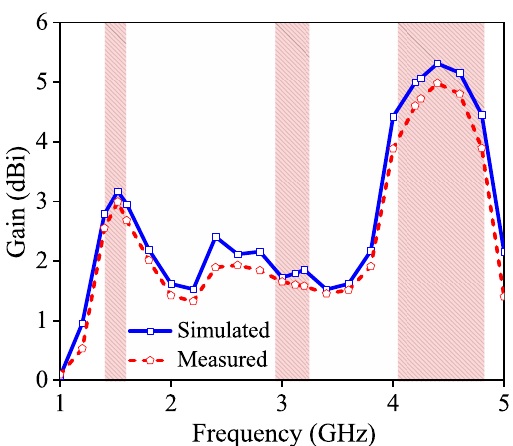
FIGURE 13: Simulated and measured radiation efficiency of proposed HDRA array.